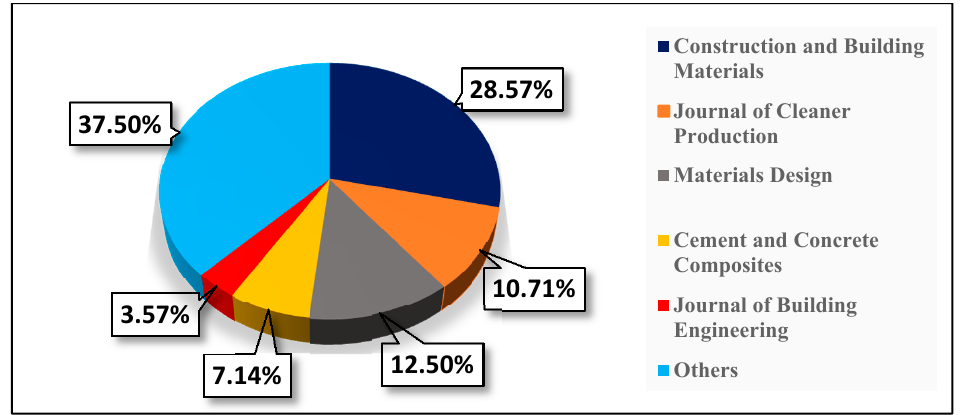
Figure 6. Percentage of articles published per journal.